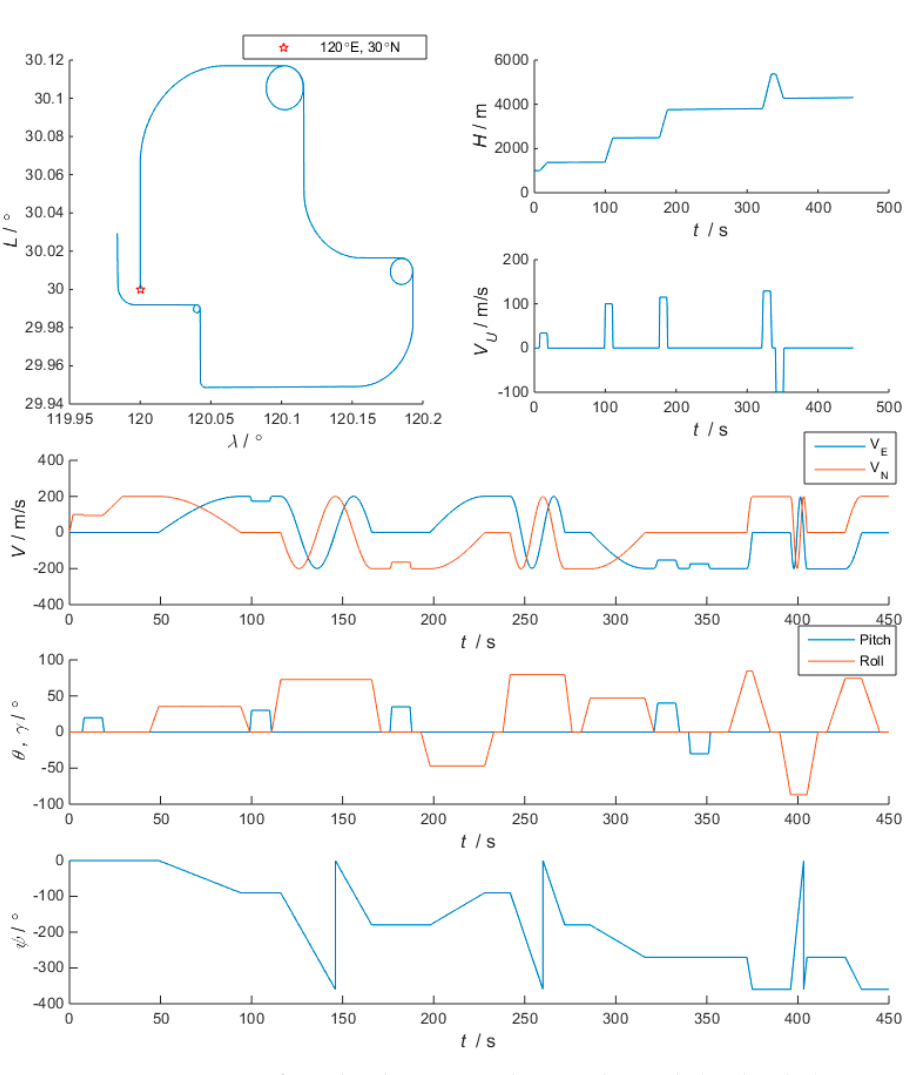
Figure 2. Diagram of simulated position, velocity and attitude (truth value).